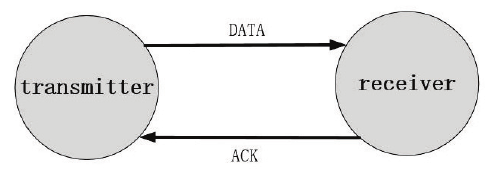
Figure 2. Reduced CSMA/CA protocol without